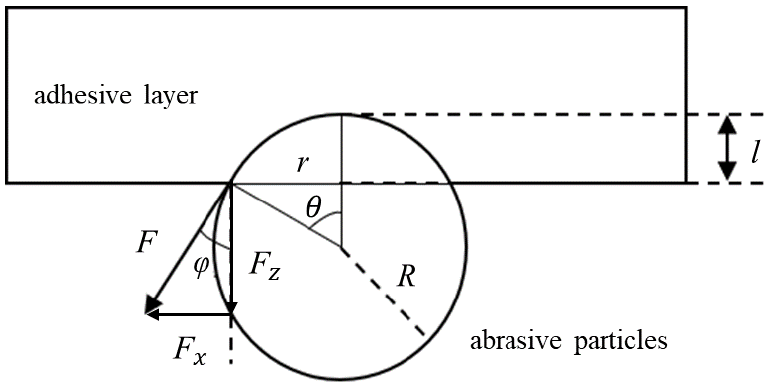
Figure 3. Diagram of viscous force.